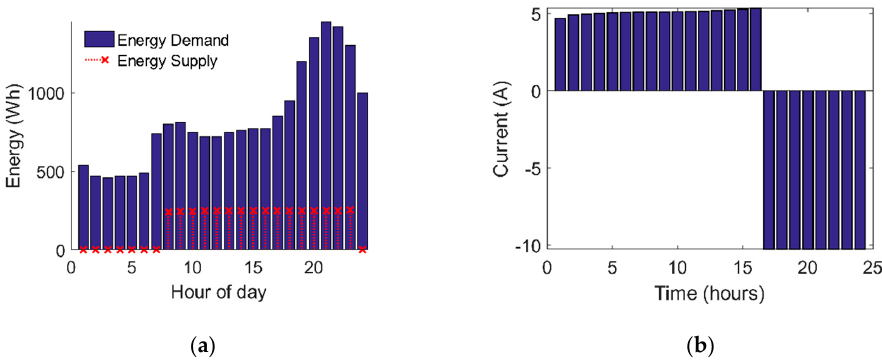
Figure 10. BESS operation schedule: ( a ) Energy distribution; ( b ) Charging and discharging currents.